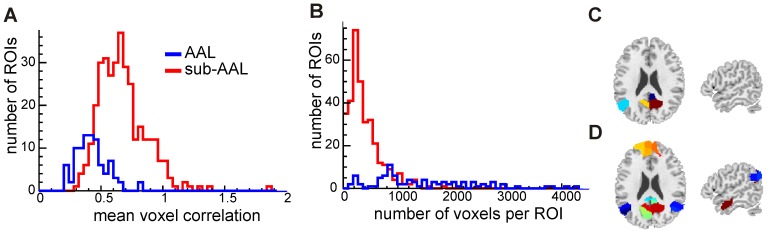
Comparison of the two parcellation approaches.A) The mean voxel correlation (Fisher transformed) within the ROIs for the parcellation according to the AAL atlas and the parcellation derived from the modular structure within the AAL regions (sub-AAL). B) The number of voxels per ROI for AAL and sub-AAL parcellation is plotted. C) ROIs significantly correlated to the left posterior cingulate cortex (PCC) ROI for the AAL parcellation. D) ROIs significantly correlated to the seed ROI in the left PCC for the sub-AAL ROIs.